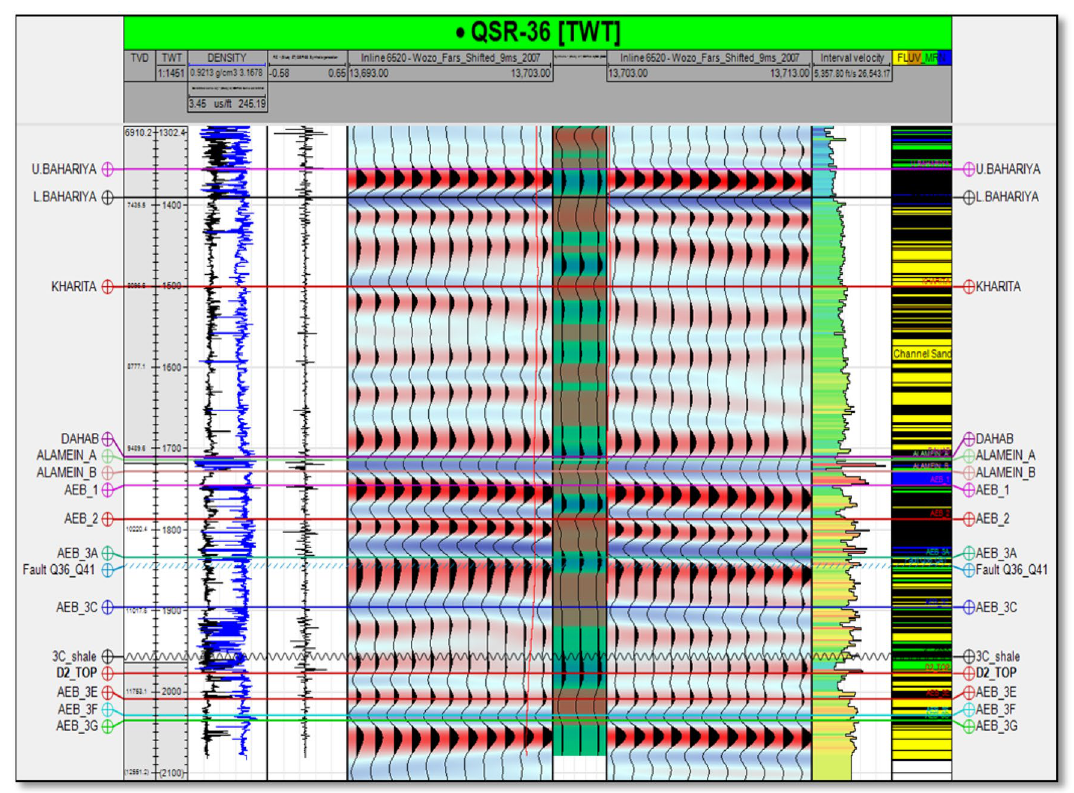
Fig. 11 Synthetic seismogram of well Qasr-36, depth–TWT relationship with linear depth scale. Note that the sandstone is shown by yellow color on the lithology column to